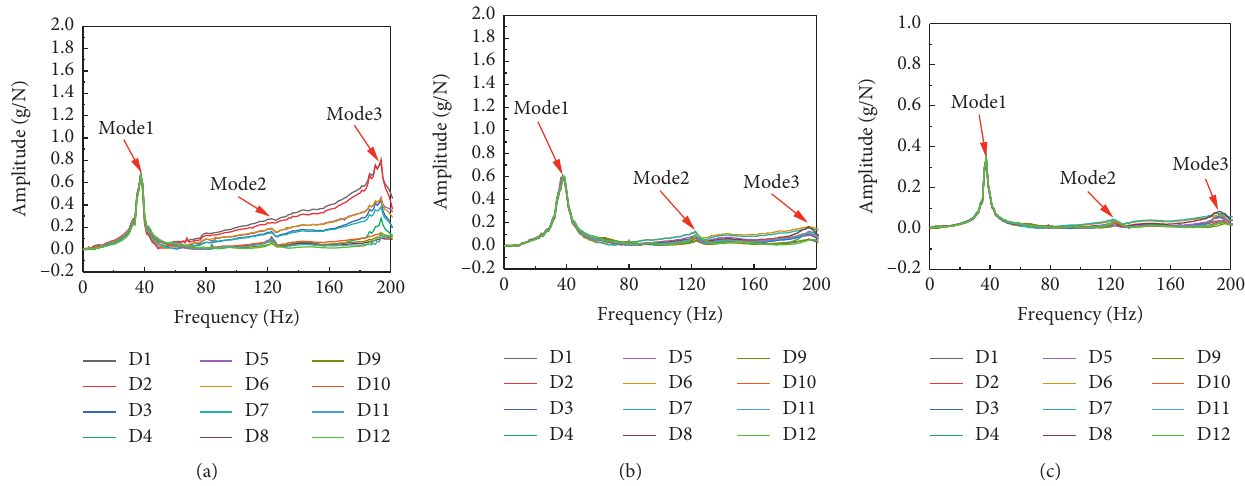
Figure 13: The FRCs of steel plate (baseplate) under different boundary conditions at different measuring points. (a) C-C-F-F, (b) C-C-C-F, and (c) C-C-C-C.